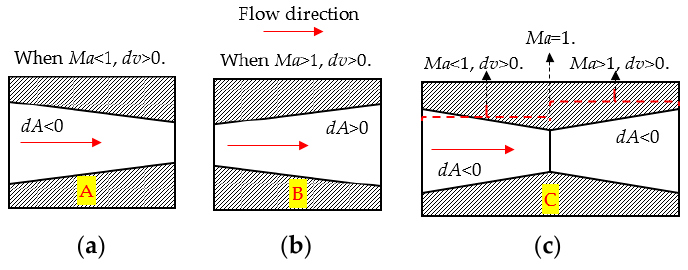
Figure 1. Schematic diagram of different types of nozzles: ( a ) Convergent nozzle; ( b ) Divergent nozzle; ( c ) Laval nozzle [26].